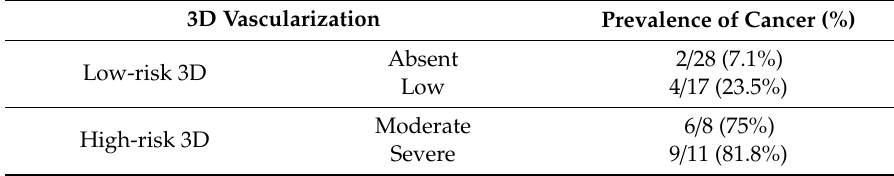
Table 3. The prevalence of malignant cases corresponding to the reported volumetric Doppler 3D evaluation.